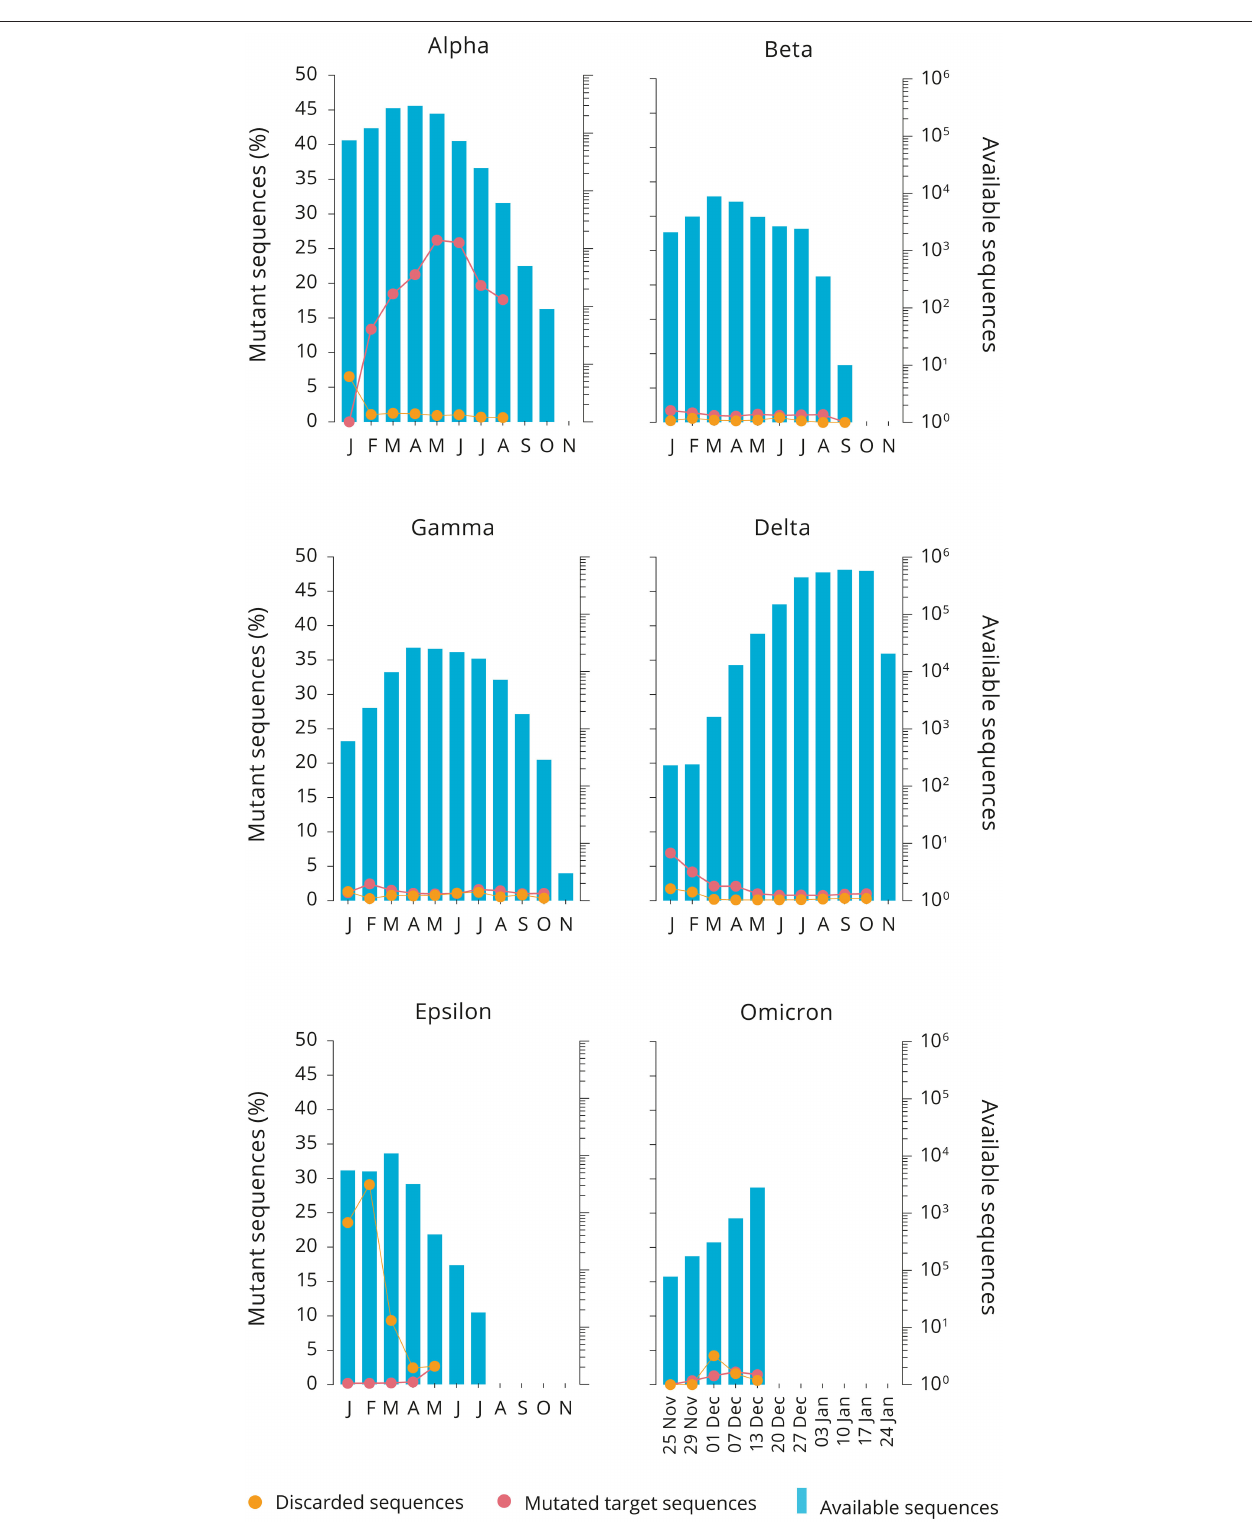
FIGURE 1 | Monthly analysis of SARS-CoV-2 variant genomes available from GISAID. The total number of sequences per month depicted by the blue bars (scale on the right-hand side of each panel). Mutated target sequences are red dots, while discarded sequences poor quality are shown as orange dots. The red line in the Alpha variant depicts the emerging mutant sequence for the forward primer ( ....................c...........